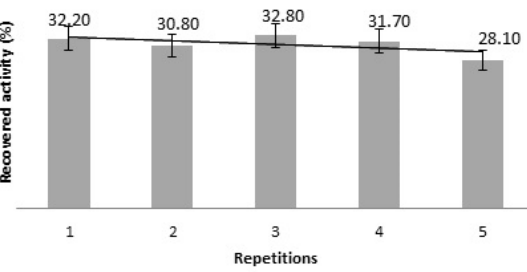
Figure 2. Optimized model validated for β -glucosidase immobilization via the CLEAs technique.